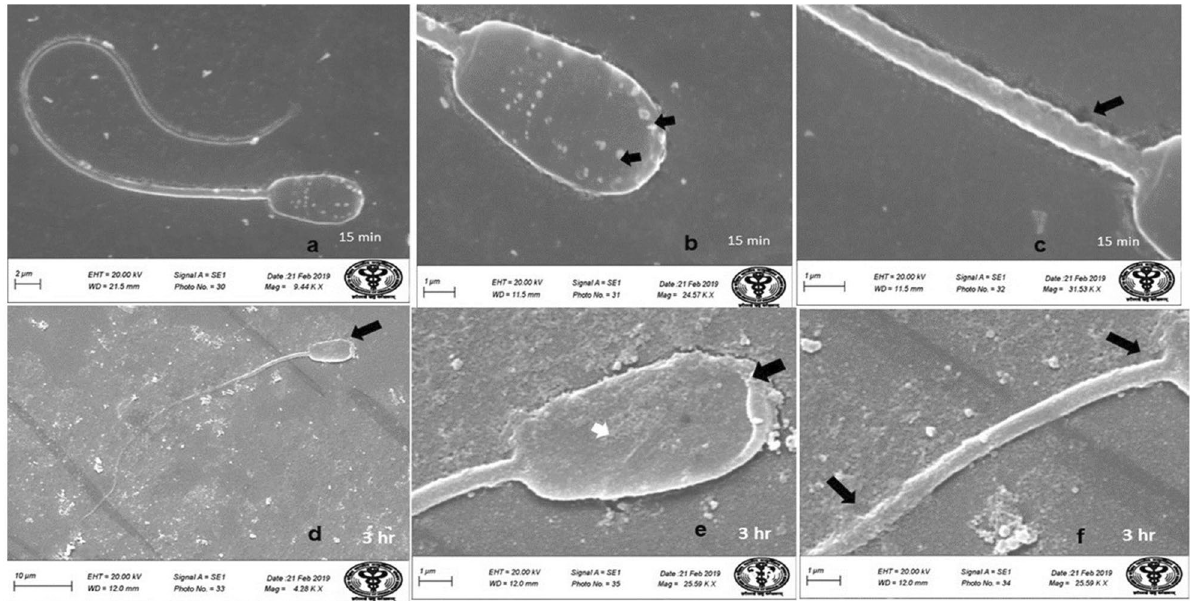
Figure 6. Scanning Electron Microscope images of goat spermatozoa in-vitro treated with Hg (1.25 µg/ml HgCl 2 ) showing deformities in overall spermatozoa ( a ), membrane damage ( b ), wavy middle piece ( a , c ) after 15 min exposure. Swollen acrosome and wrinkled head plasma membrane ( d , e ), damaged tail and the neck having irregular plasma membrane ( f ) after 3 h exposure of 1.25 µg/ml HgCl 2